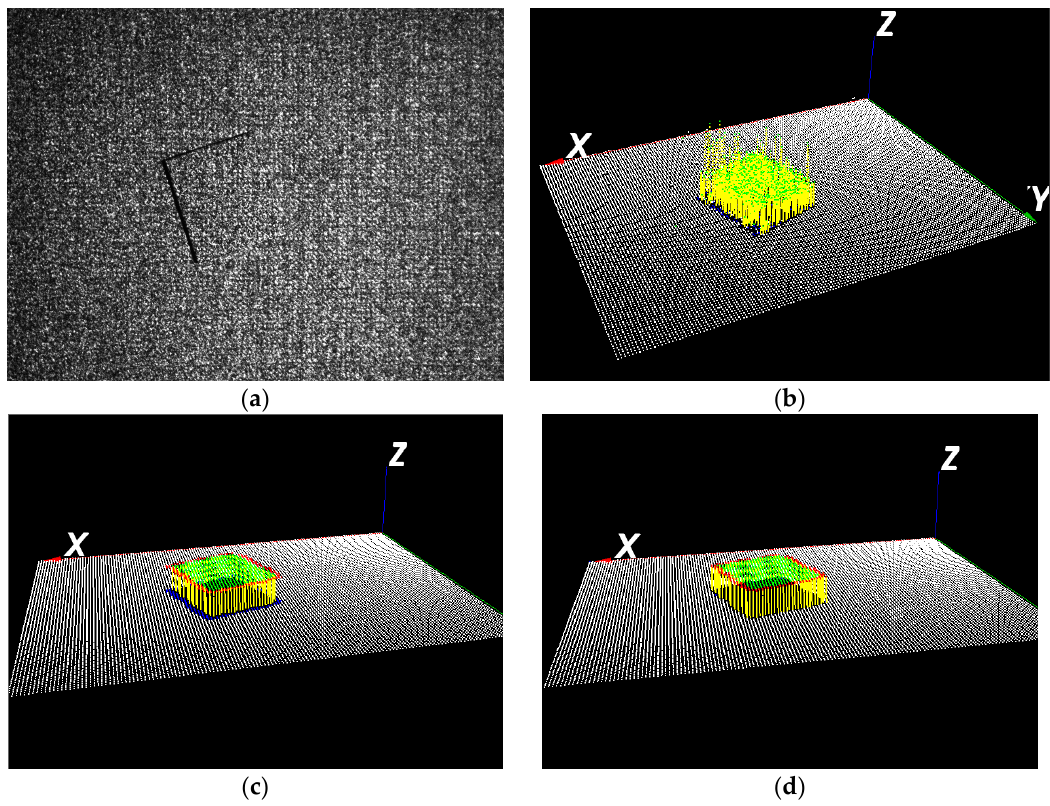
Figure 14. Measurement results obtained using the proposed approach for reconstruction of the pre-calibrated gauge block: ( a ) speckle image; ( b ) 3D result measured using traditional DIC; ( c ) initial edge reconstruction using the proposed approach, in which some edge positions are still missing from its original object shape; and ( d ) 3D map reconstructed using the proposed edge detection method.